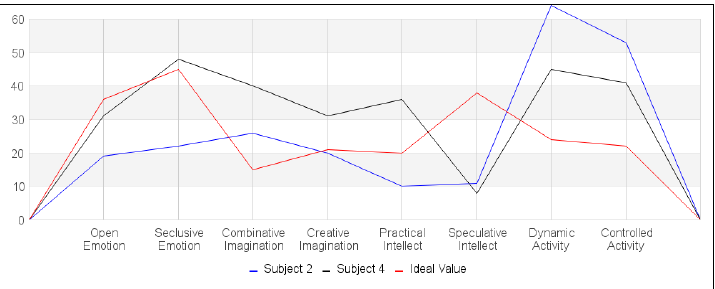
Fig. 8. Comparison graph of the characters values of Subject 2 and Subject 4 against the ideal